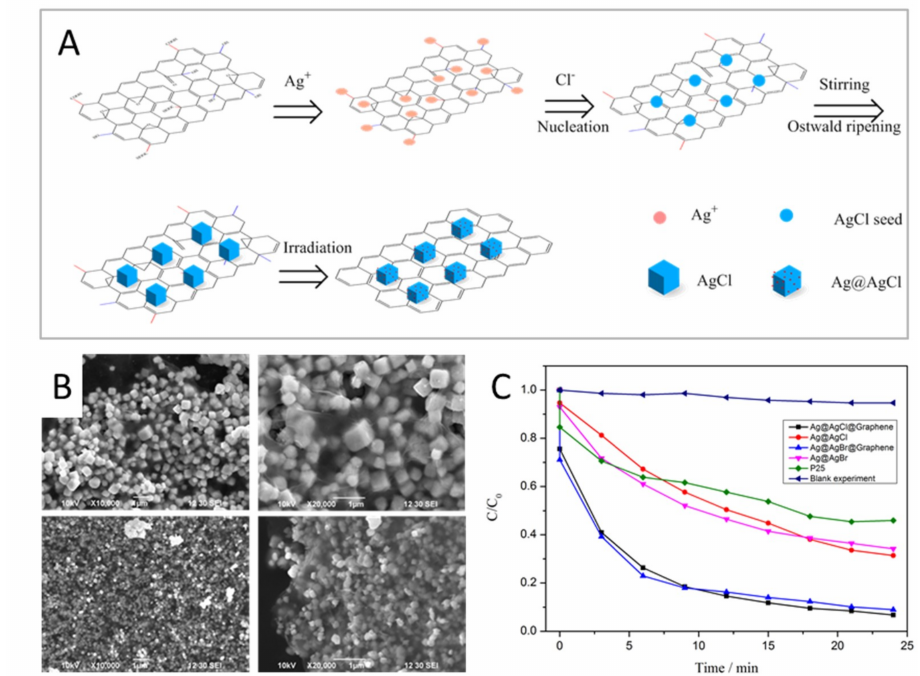
Figure 11. Schematic explanation for morphology evolution of the representative